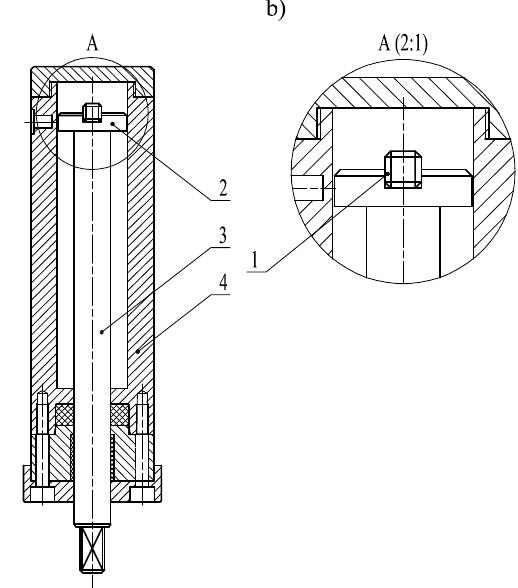
Figure 6. Cylindrical attrition tribotester ( a ), and bar-specimen ( b ) with square cross-section, where: 1—specimen, 2—disc-specimen holder, 3—driving shaft, 4—cylindrical container.